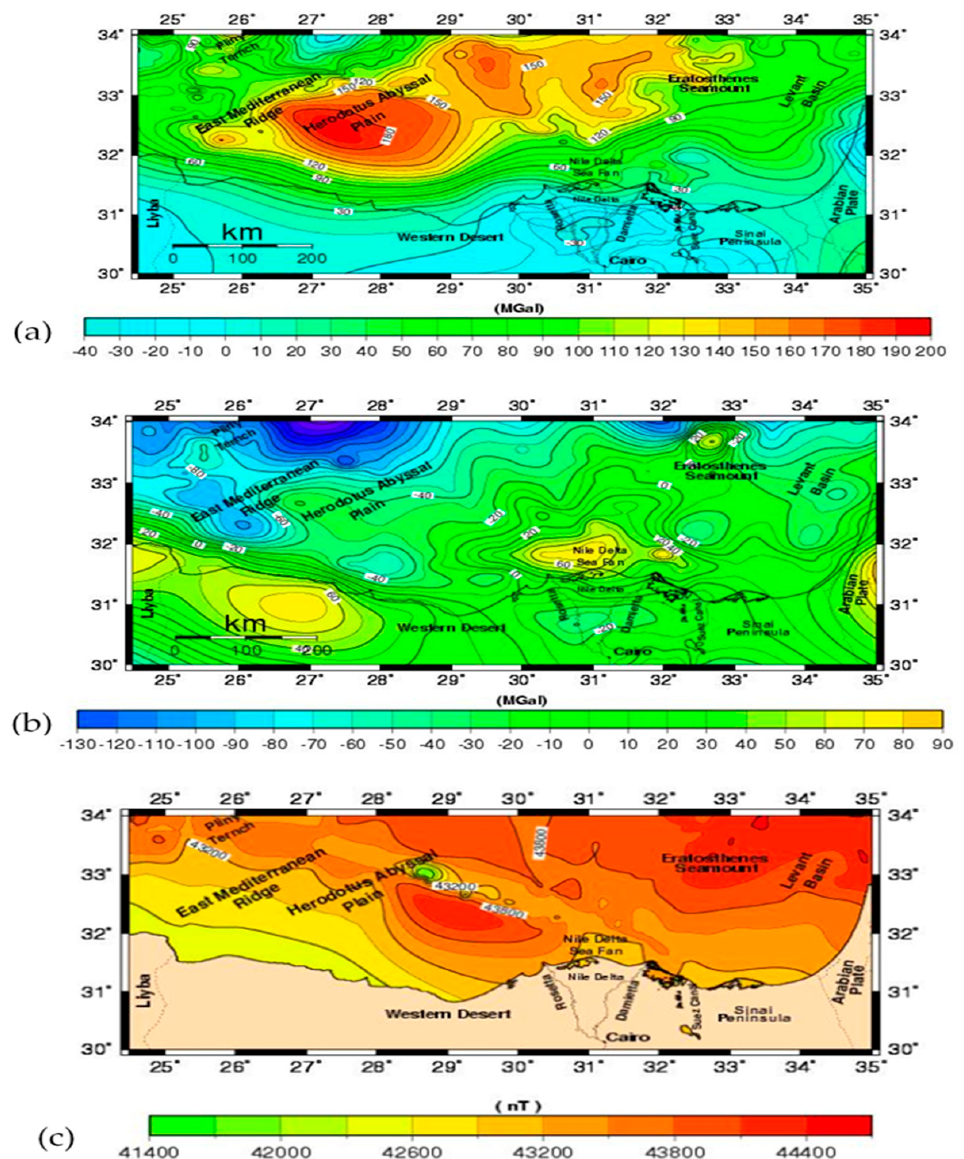
Figure 2. ( a ) Bouguer gravity map; ( b ) free-air gravity map; and ( c ) total intensity magnetic anomaly map of the area investigated.